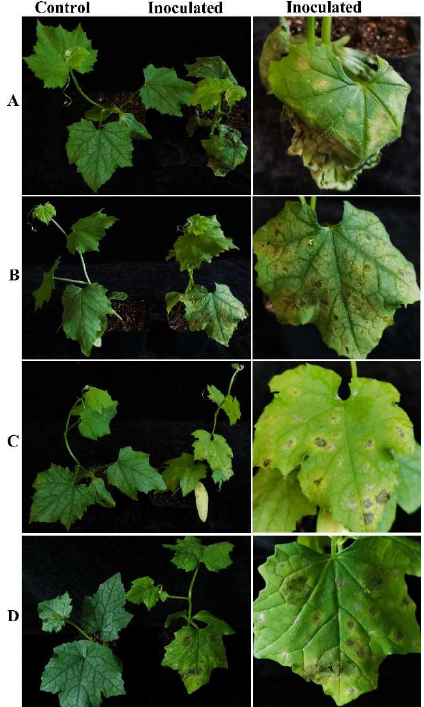
Figure 4. Pathogenicity test of strains CSSGY1, CSSGY4, CSSGY5-1, and CSSGY5-2 on luffa sponge gourd plants. ( A – D ) Symptoms of potted sponge gourd plants that were artificially inoculated with Colletotrichum isolates of ( A ) CSSGY1, ( B ) CSSGY4, ( C ) CSSGY5-1, and ( D ) CSSGY5-2. The left and right plants indicate the control and inoculated plants, respectively. After 5 days of inoculation, all the inoculated sponge gourd leaves developed symptoms. No obvious symptoms developed on the control plants.